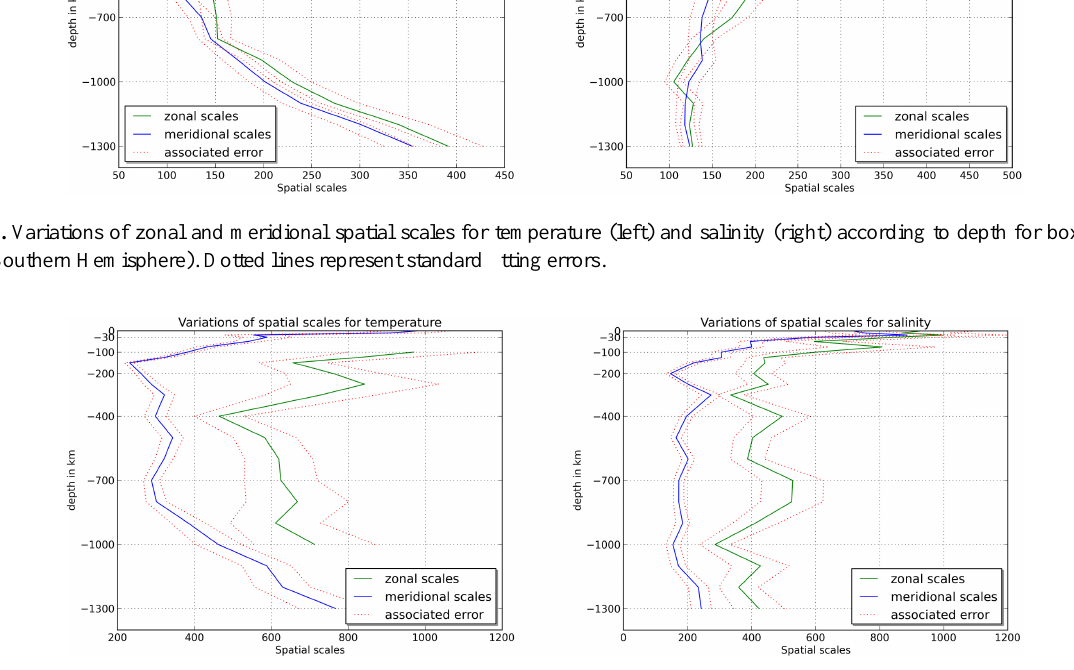
Figure 8. Variations of zonal and meridional spatial scales for temperature (left) and salinity (right) according to depth for box 9 (equatorial Indian and Pacific). Dotted lines represent standard fitting